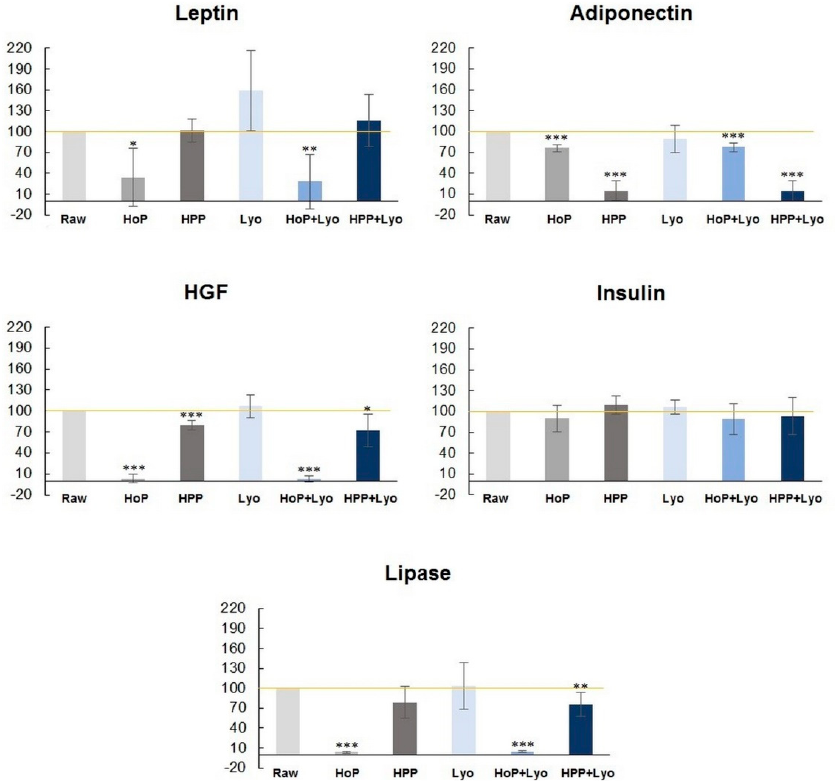
Figure 2. Changes in leptin, adiponectin, hepatocyte growth factor (HGF), insulin, and lipase concentrations (%) in processed human milk versus raw milk (Raw) (100%). The data are presented as mean values with the standard error of the mean. The percentage of the concentrations of the selected bioactive components in milk samples subjected to Holder pasteurization (HoP), high-pressure processing (HPP), freeze-drying (Lyo), HoP + Lyo, and HPP + Lyo (at time 0) compared to raw human milk (100%). Statistically significant differences are marked with asterisks, depending on the degree of significance: *** p < 0.0001, ** p < 0.001, * p < 0.05.